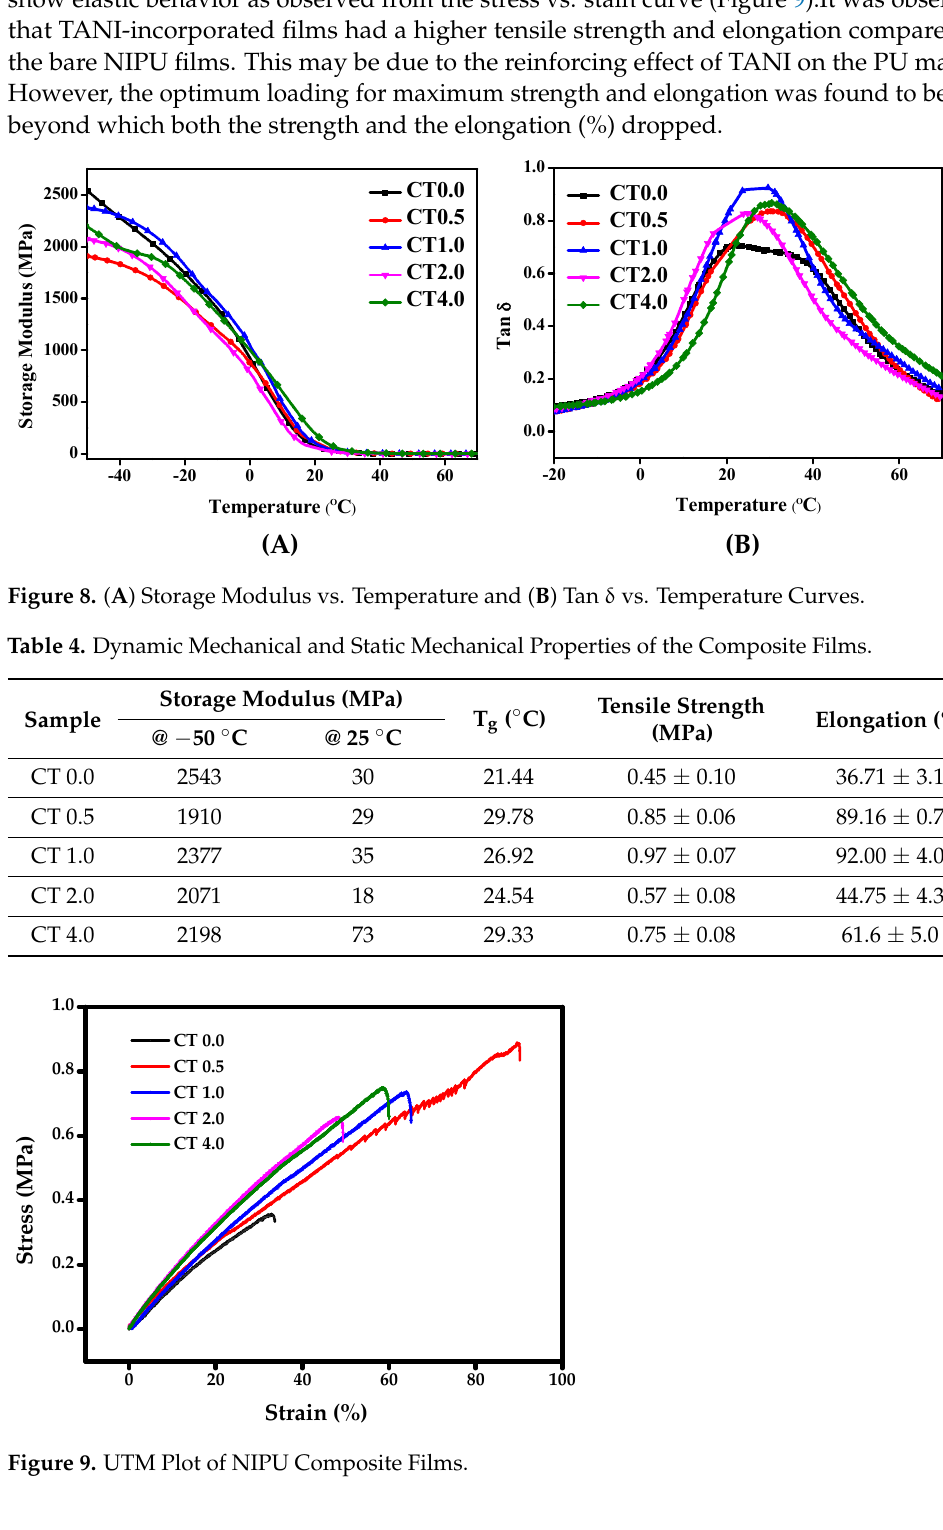
Table 4. Dynamic Mechanical and Static Mechanical Properties of the Composite Films .